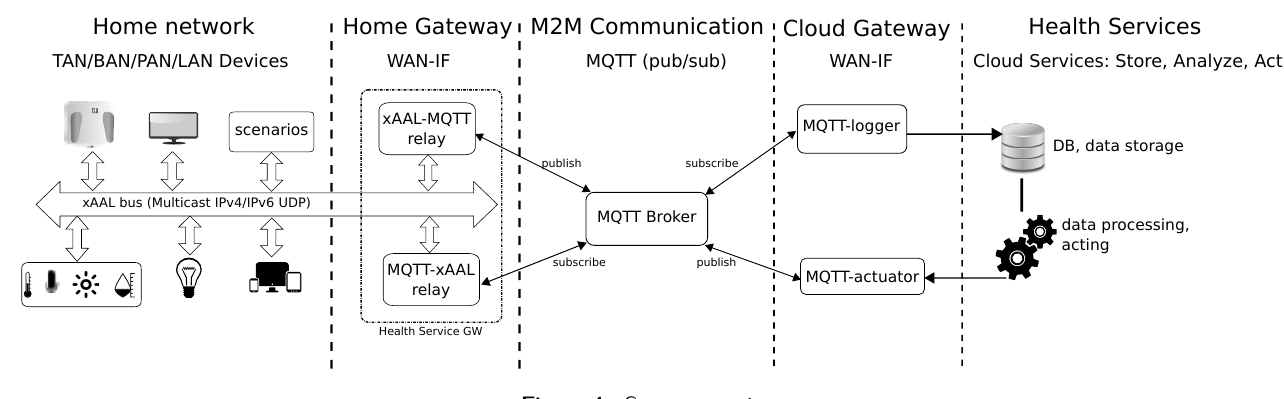
Figure 1. System